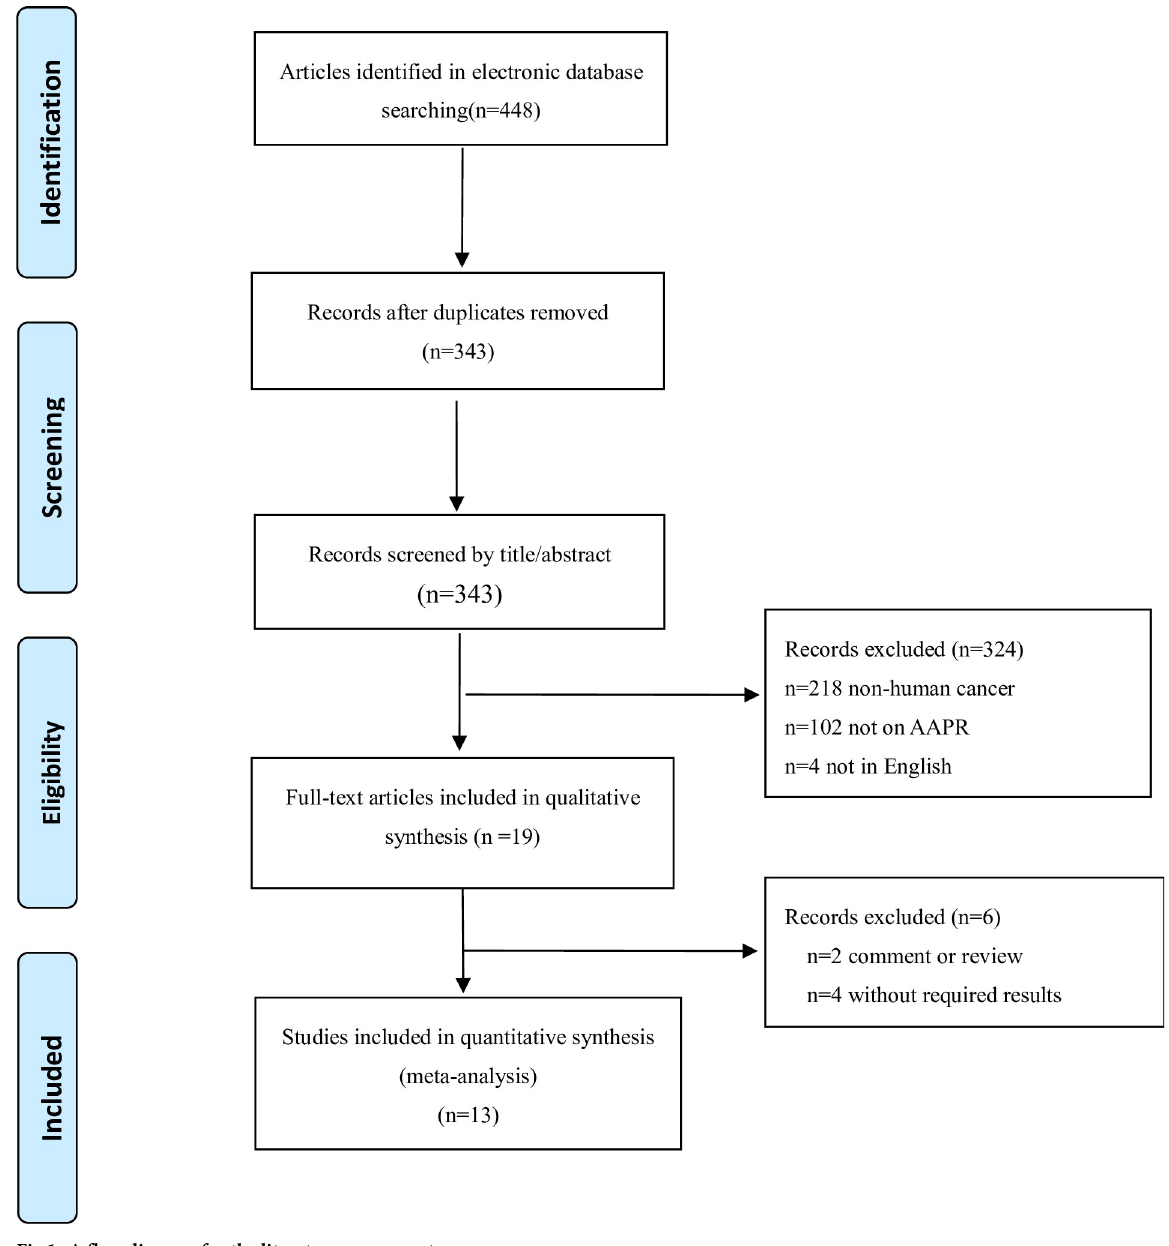
Fig 1. A flow diagram for the literature assessment